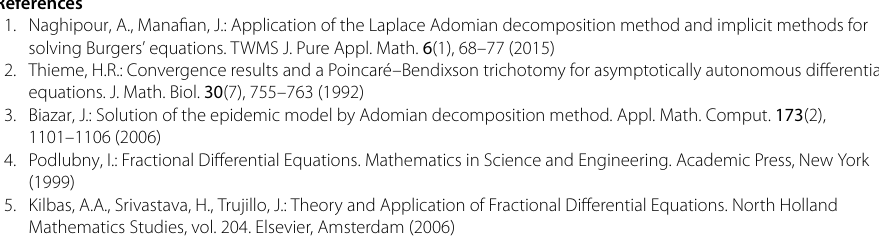
from qualitative and analytical aspects. By using fixed point approach, the existence of the model has been verified. Also, by combining the Laplace transform with the decomposi- tion method, some approximate analytical results have been established under two